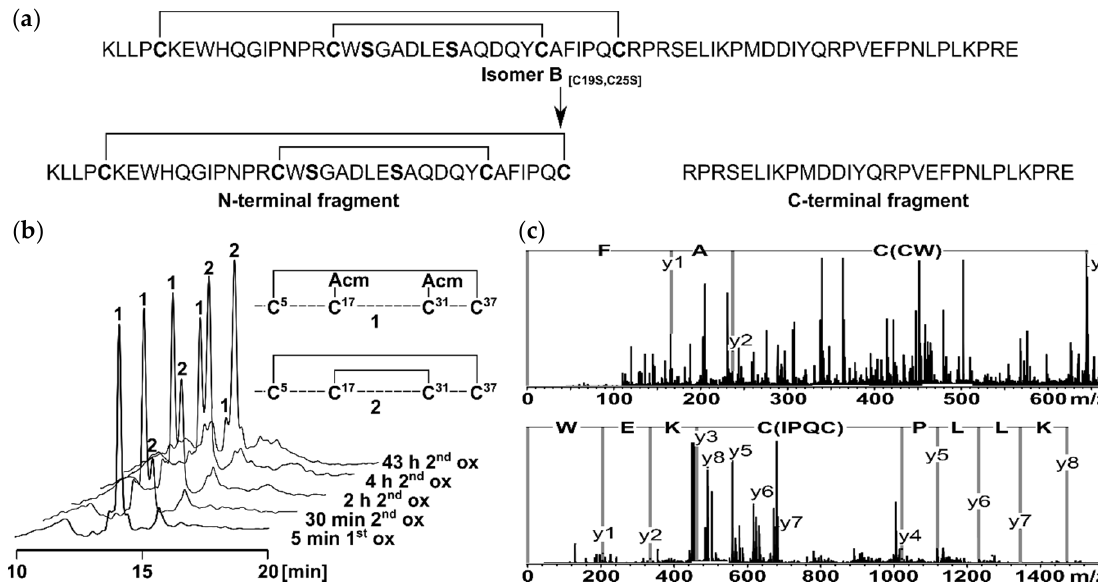
Figure 1. ( a ) Derivation of the two fragments from the two-disulfide-bonded tridegin isomer B [C19S,C25S] [29]. The N-terminal fragment consists of amino acid 1–37 and contains the disulfide bonds Cys5–Cys37 and Cys17–Cys31. The C-terminal fragment is composed of amino acids 38–66 without a cysteine residue; ( b ) HPLC elution profiles of the stepwise oxidation strategy applied for the synthesis of the N-terminal fragment. During the first oxidation (1.1 eq. iodine, 100% AcOH) the first disulfide bond between Cys5 and Cys37 was formed (1). Subsequently the second disulfide bond between Cys17 and Cys31 was built (2) by increasing the amount of iodine (15 eq.) and adjusting the concentration of AcOH (70%); ( c ) MS/MS analysis of the N-terminal fragment after digestion with chymotrypsin. The disulfide bond connectivity was confirmed by the characteristic MS/MS fragments C(CW) AF and KLLP C(IPQC) KEW.